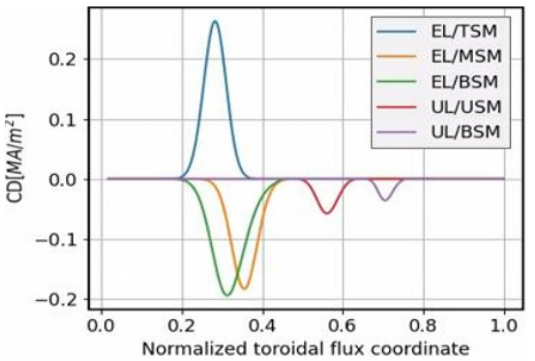
Fig. 7. ECCD profiles from X2 absorption simulated by TORBEAM for a JINTRAC 7.5 MA / 2.65 T H scenario.